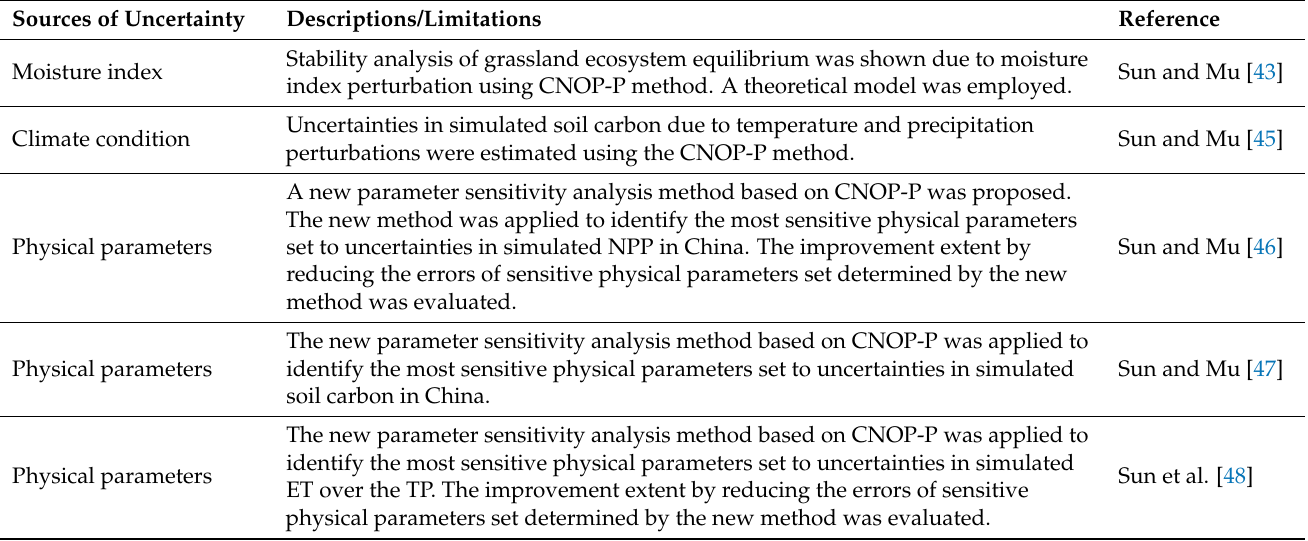
Table 1. Summary of the studies of terrestrial ecosystem predictability using the CNOP-P